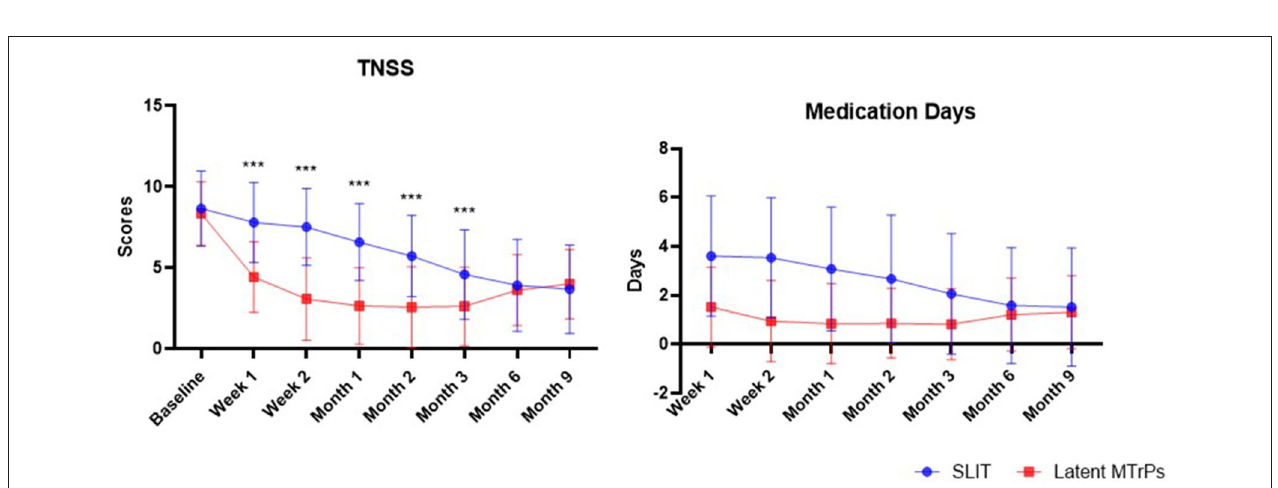
FIGURE 3 | Effect of the SLIT and latent MTrPs injection on nasal and eye symptoms during the 9 months follow-up period in patient with AR. *: p < 0.05, **: p < 0.01, and ***: p < 0.001. SLIT, sublingual immunotherapy; MTrPs, myofascial trigger points.